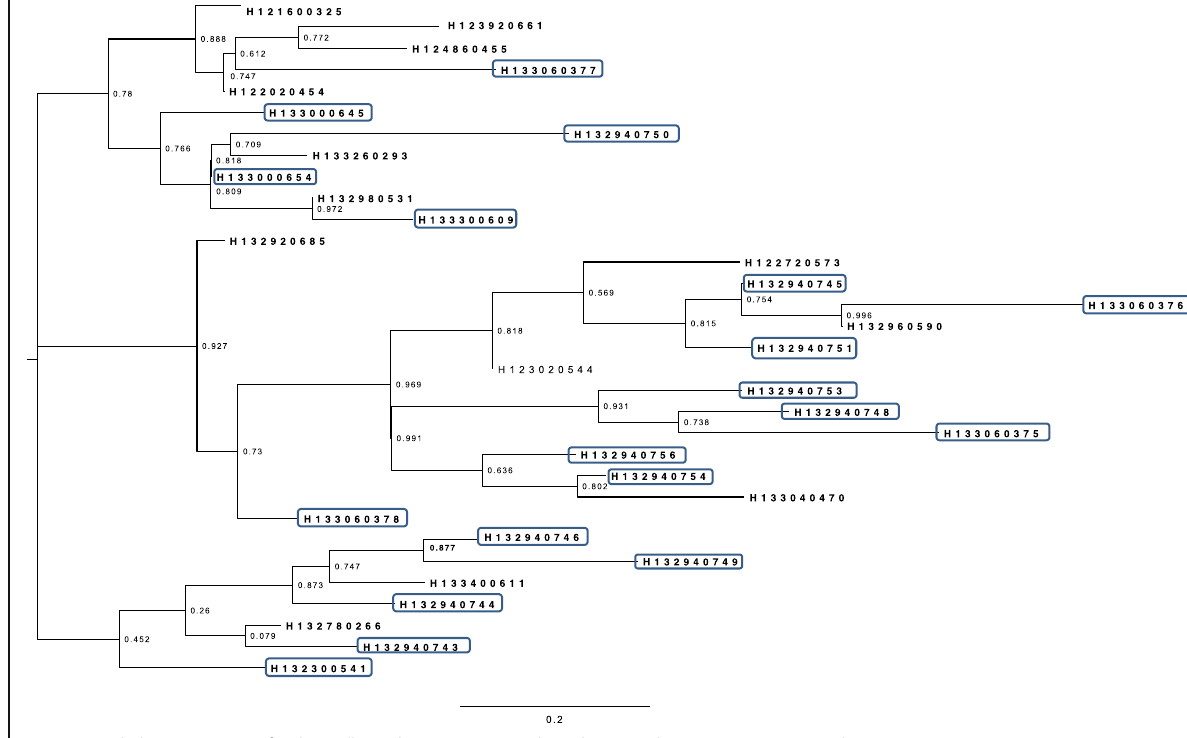
Fig. 6 ML phylogenetic tree of Salmonella Typhimurium strains based on prophages SNPs using